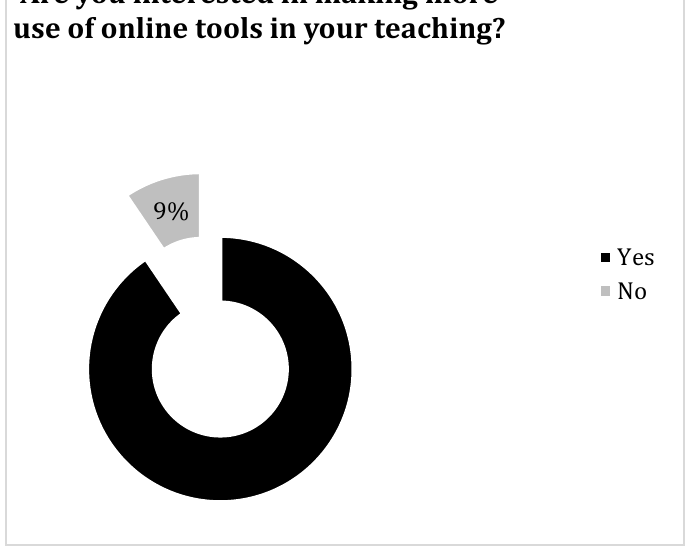
Figure 8: Future use of online tools in